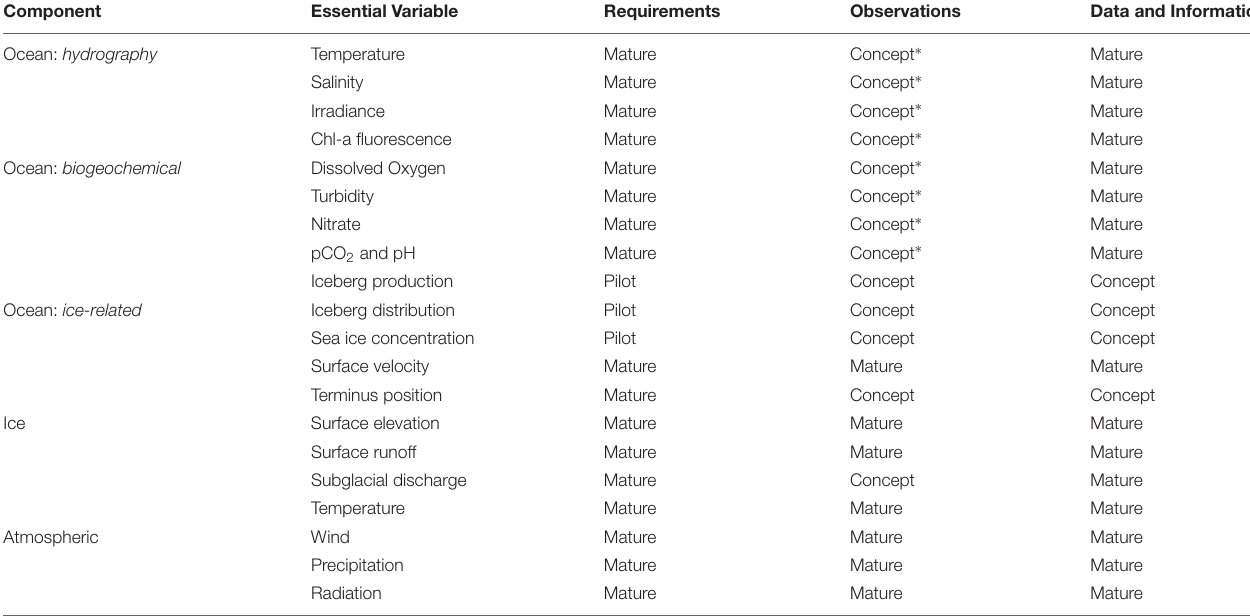
TABLE 1 | GrIOOS essential variables, with information about readiness levels for component requirements, observation instruments and methods, and data and information